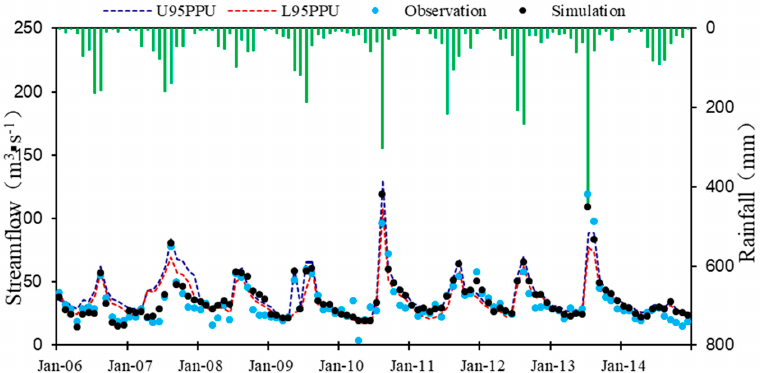
Figure 4. RunoffsimulationoftheXiaoqingRiverbasinincalibrationandvalidationperiods95PPUbasedonSUFI-2. Figure 4. Runoff simulation of the Xiaoqing River basin in calibration and validation periods 95PPU based on SUFI-2.